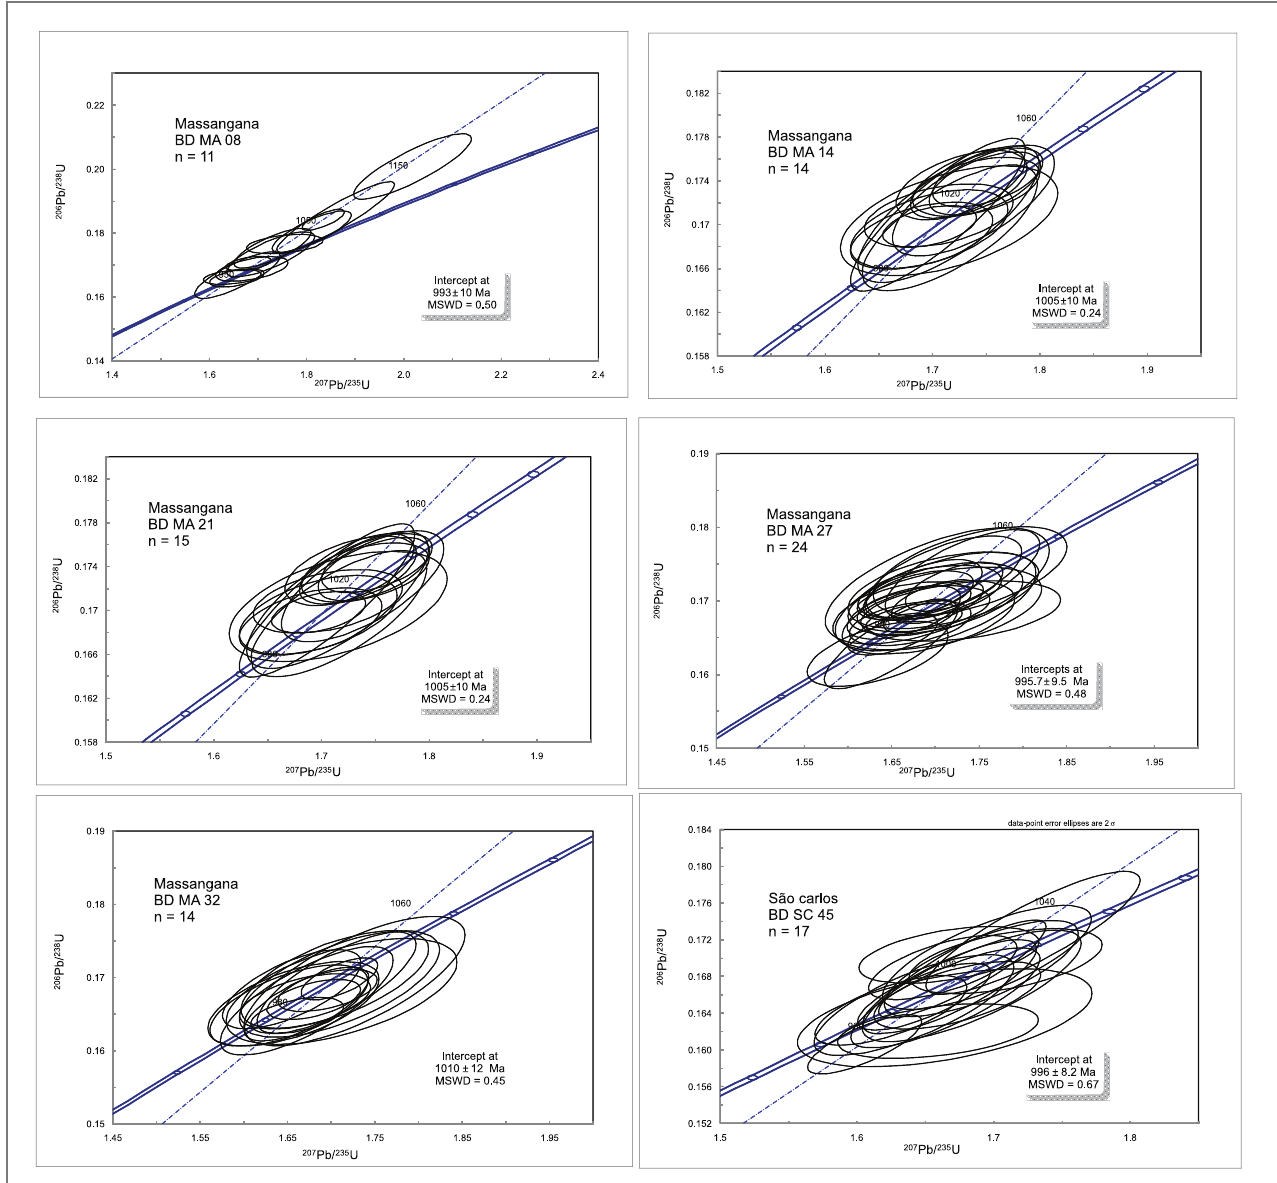
FIGURE 5 – Concordia diagrams showing U-Pb ages in zircon grains form Massangana and São Carlos